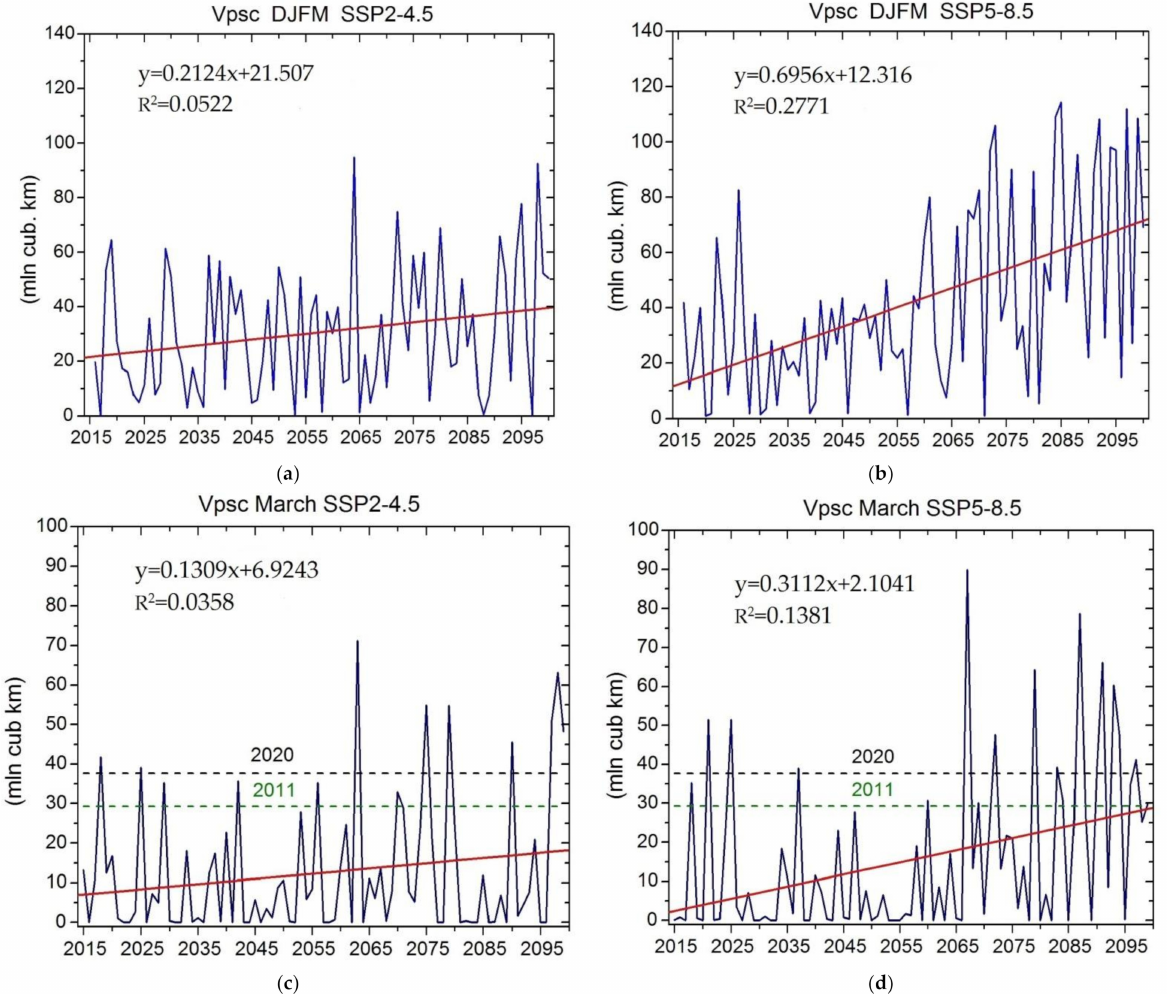
Figure 4. Vpsc variability from 2016 to 2100 under moderate and severe scenario averaged over December–March ( a , b ) and in March ( c , d ). Red lines correspond to linear trend, while dashed horizon- tal lines correspond to Vpsc values in March 2011 and March 2020 according to MERRA-2